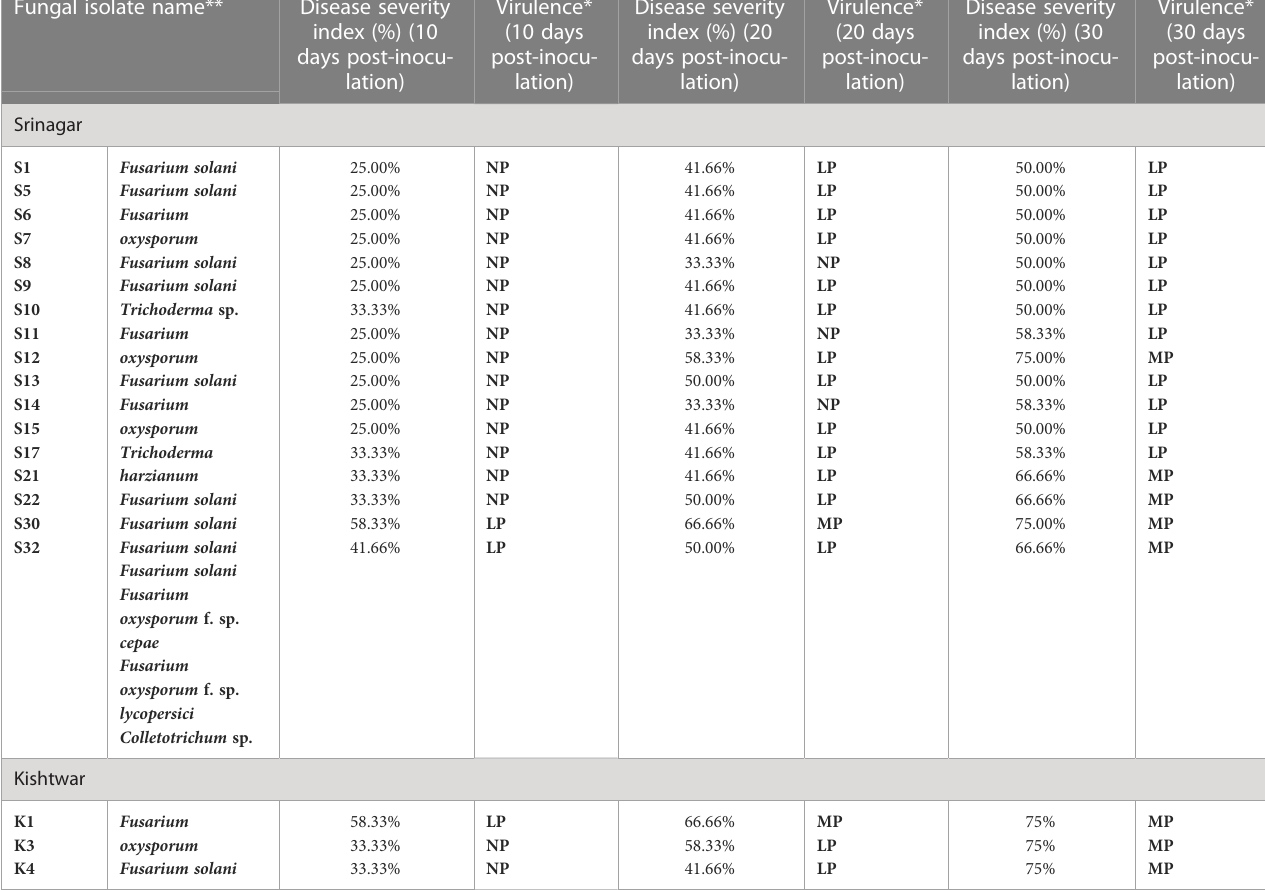
TABLE 4 Corm rot pathogenicity pro fi ling of fungal species isolated from Srinagar, Kishtwar, and Ramban location. Fungal isolate